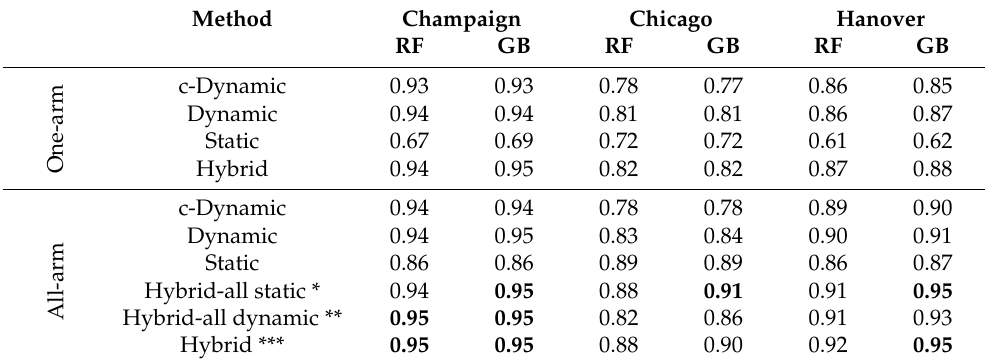
Table 4. Classification accuracy of the TRR models. The best performance per dataset is shown in